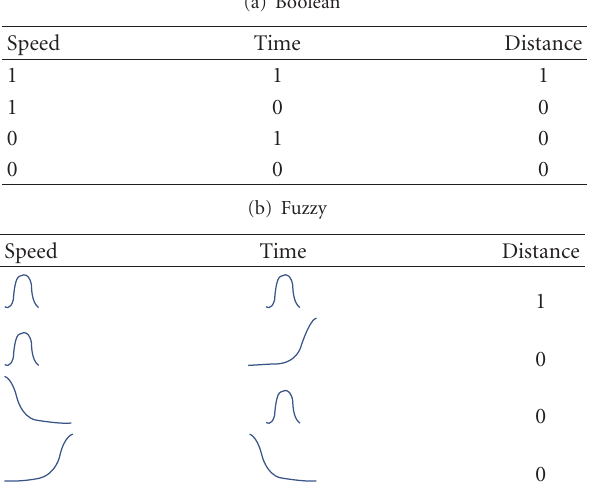
Table 2: A Boolean and fuzzy truth table TOF detector. (a)